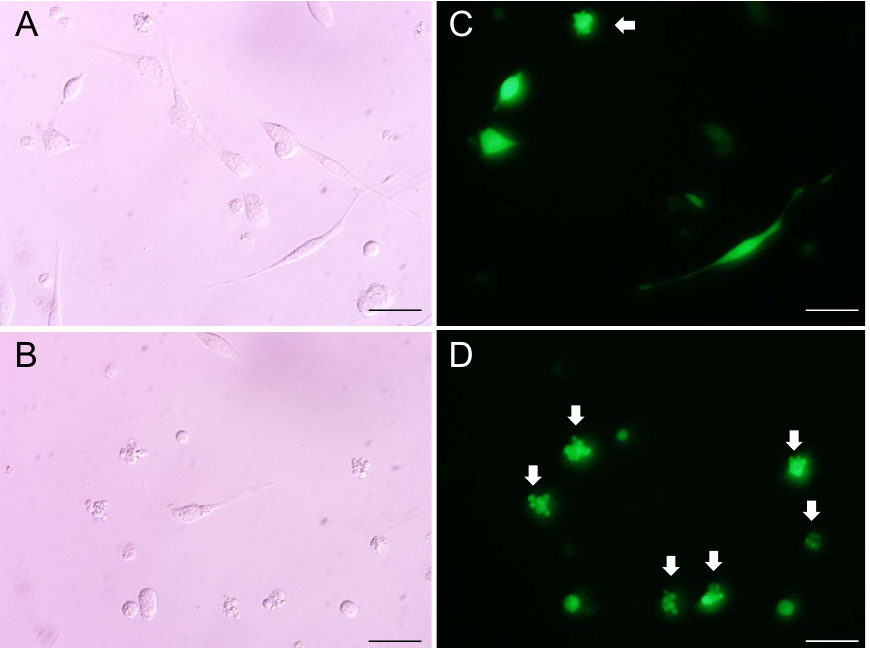
Figure 5. Analysis of cell death after mPG1 transfection using light and fluorescence microscopy. EGFP signals were compared between NIH3T3 ( A , C ) and 661W ( B , D ) cells after transfection with EGFP-mPG1. Arrows indicate cells undergoing cell death based on cell fragmentation. Scale bars represent 50 μm.